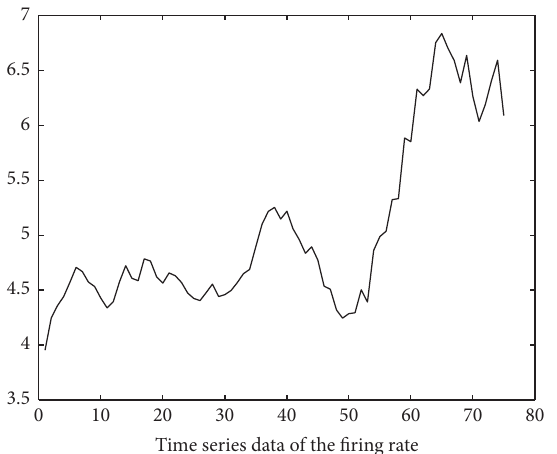
Figure 14: Firing rate series of SpeficyPaymentMethod.